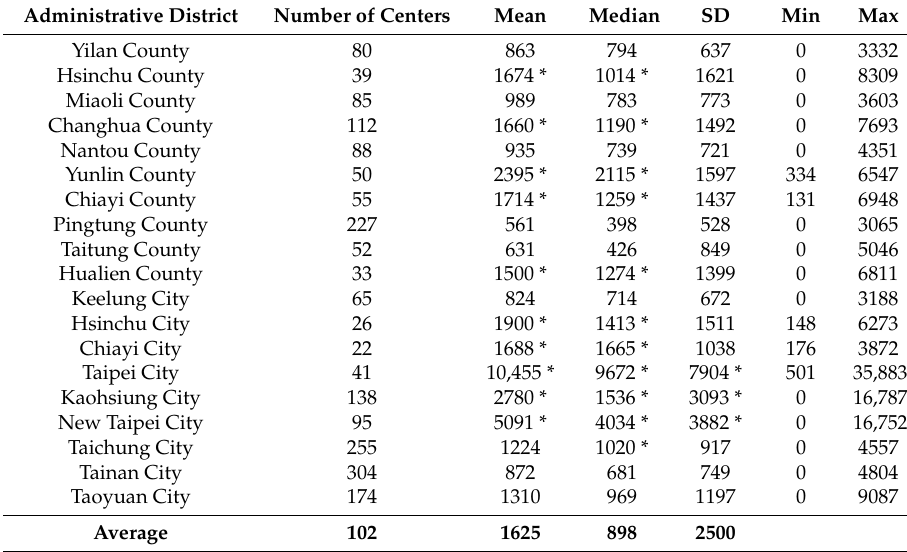
Table 5. Summary statistics of the community care centers’ loading measures (in people) as identified using method